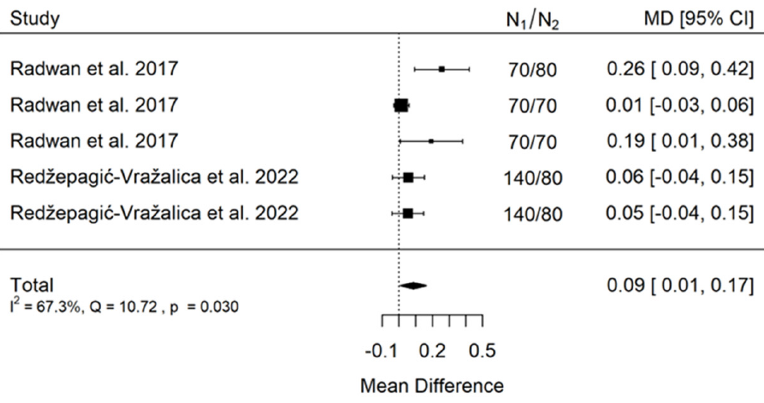
Figure 12. Forest plot for evalutaion of thread shape factor infulence on pull-out strentght in animal bone model studies [38,44].